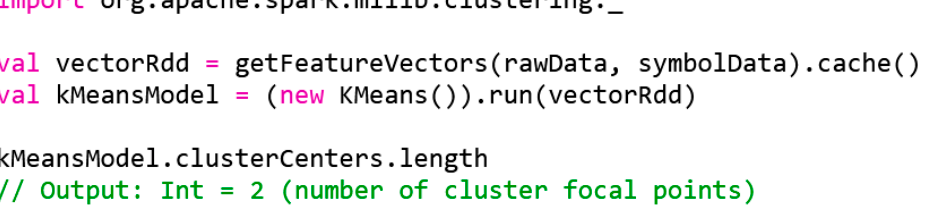
Figure 9. k-means model generation.